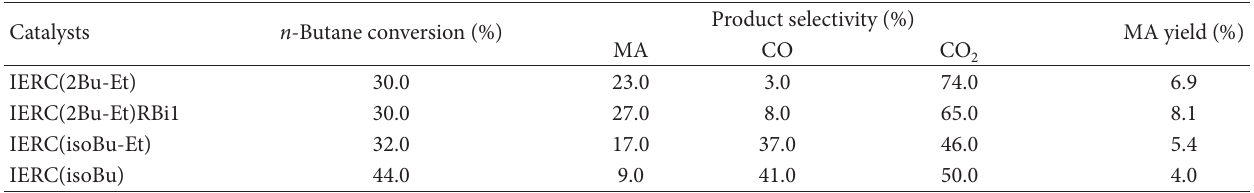
T 3: e catalytic performance of doped and undoped intercalation-exfoliation-reduction catalysts using different mixture of solvent for oxidation of n